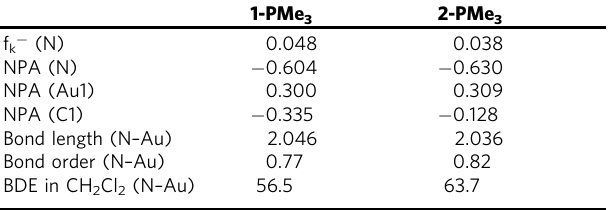
Table 1 Calculated data of 1-PMe 3 and 2-PMe 3